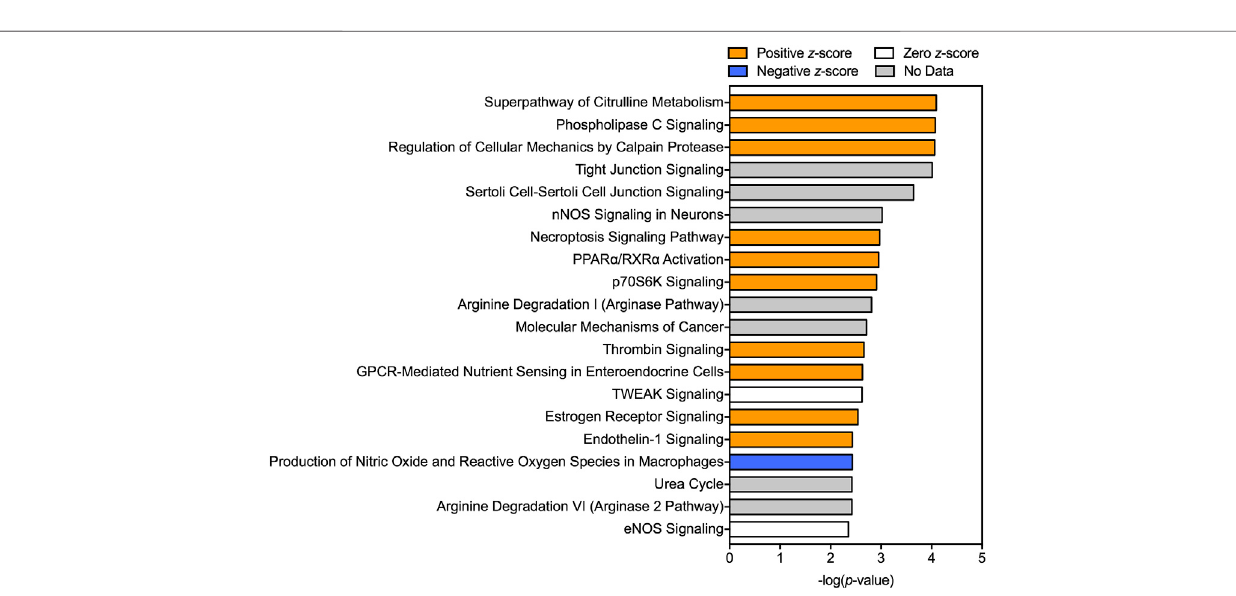
Frontiers in Environmental Science |